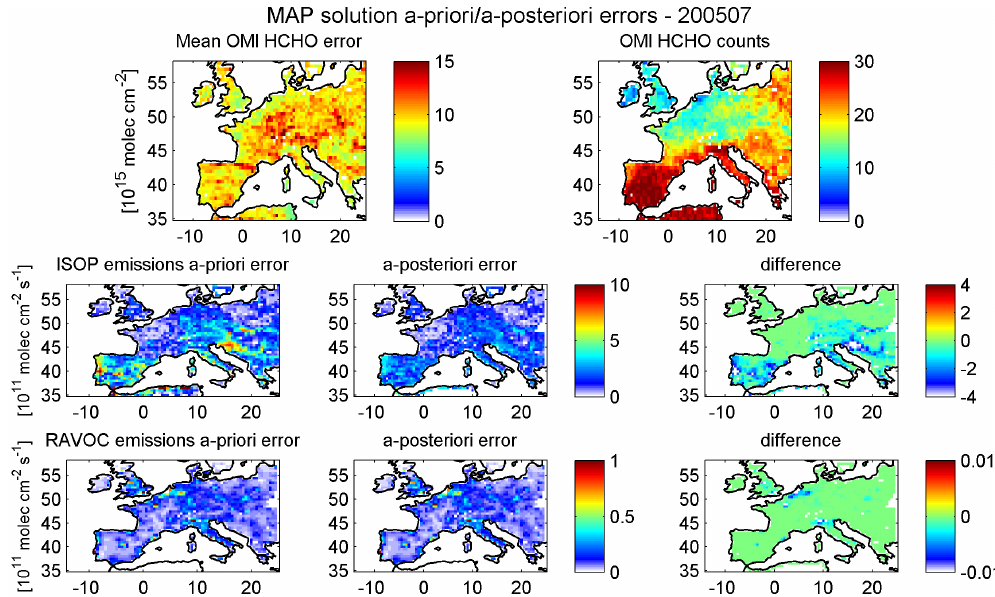
Fig. 5. Estimated observational error related to OMI HCHO column observations (10 15 moleculescm − 2 ) , and a-priori and a-posteriori errors related to biogenic and anthropogenic VOC emissions (10 11 moleculescm − 2 s − 1 ) , for July 2005. a-posteriori errors are reduced exploiting OMI information content through the MAP